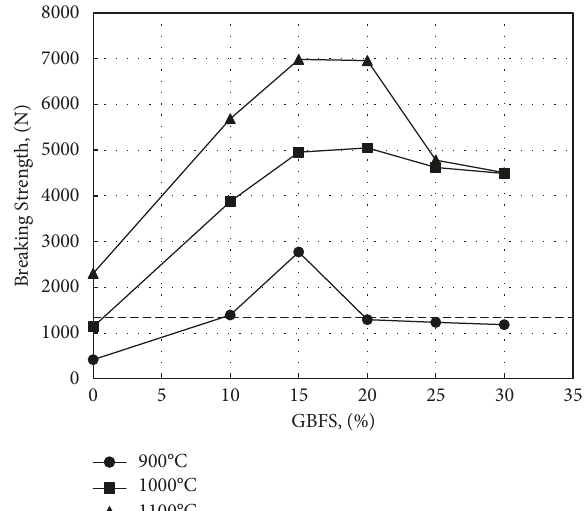
Figure 15: Effect of GBFS Addition on breaking strength. (Dotted line corresponds to minimum value following ASTM C1167).